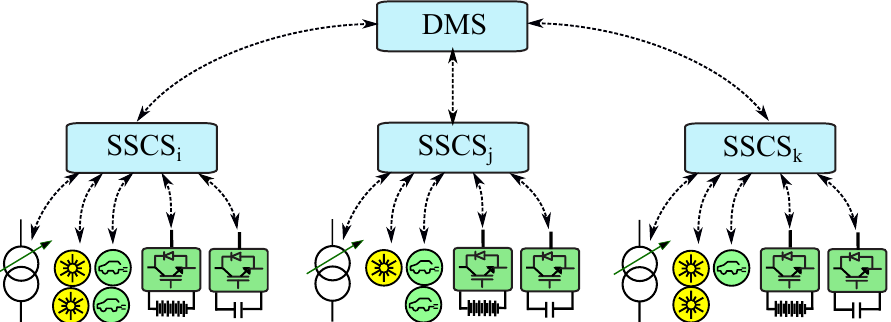
Figure 5. Hierarchical control of active distribution